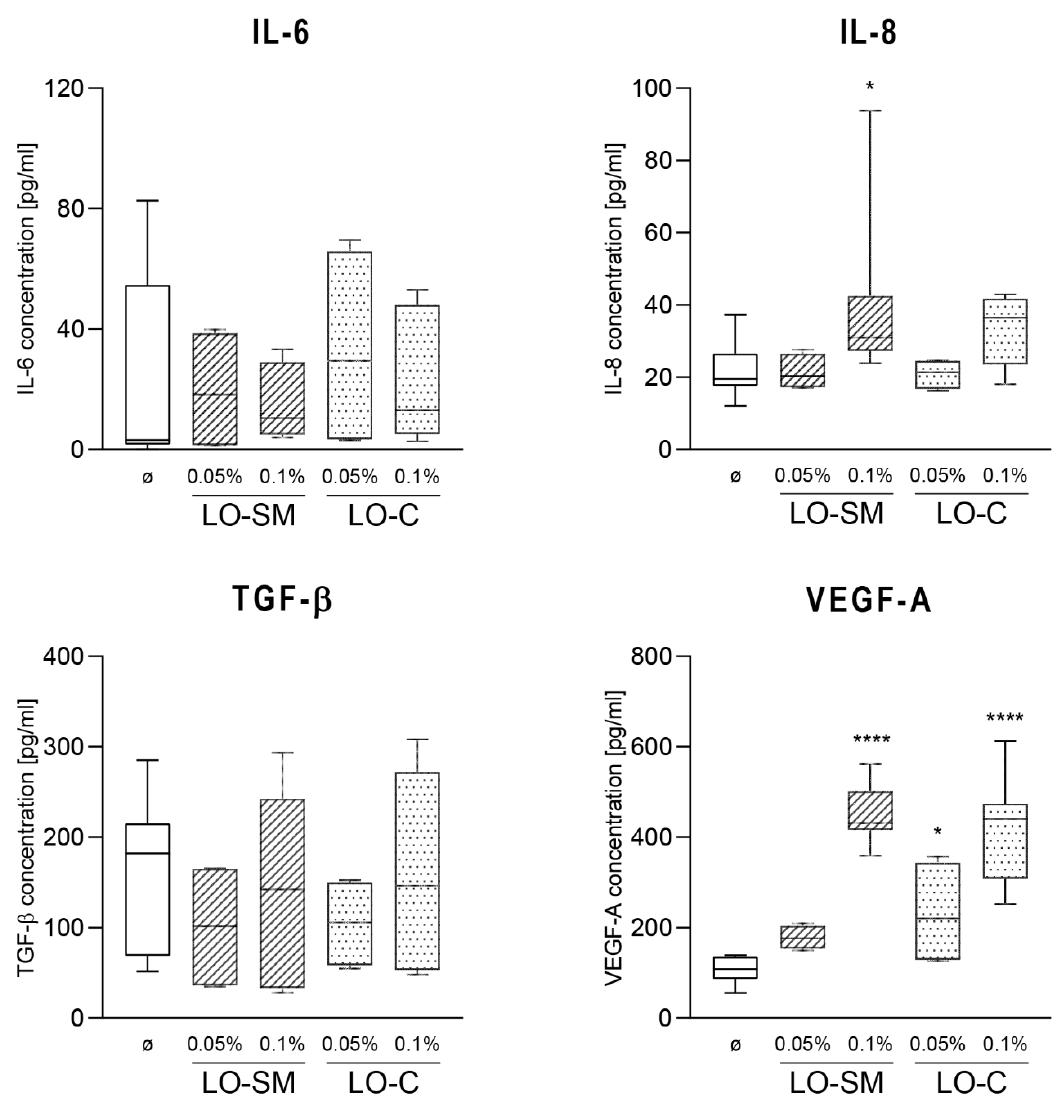
Figure 4. Effect of lavender oil stimulation on the cytokines production in HaCaT cell line. HaCaT cells were stimulated with designated concentrations ( v / v ) of commercial or in-house preparation of lavender oil for 24 h. Level of cytokine in cell media: IL-6, IL-8, TGF- β , VEGFA were verified with ELISA. Values are mean with range. Groups were compared to the control, and statistical analysis was performed using GraphPad Prism and build-in ANOVA test. p -values ≤ 0.05 were considered significant. *— p = 0.05–0.011; ****— p ≤ 0.0001.